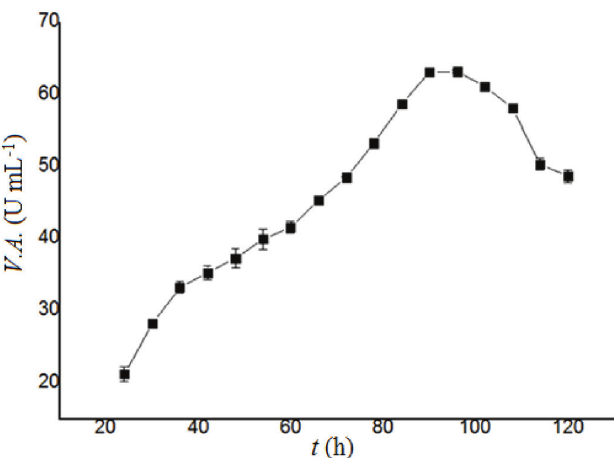
Fig. 5 – Effect of fermentation time on enzyme activity (with pH 6, alginate concentration 20 g L –1 , rotation rate 120 rpm, and temperature 35 °C) Table 1 – Gel chromatography results at different periods Enzyme activity, Time (min)